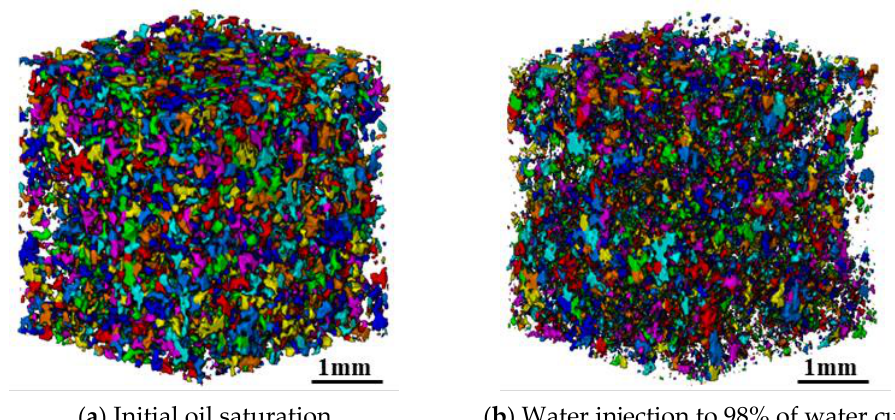
Figure 5. Division of oil droplets during water flooding in the No. 2 rock sample.